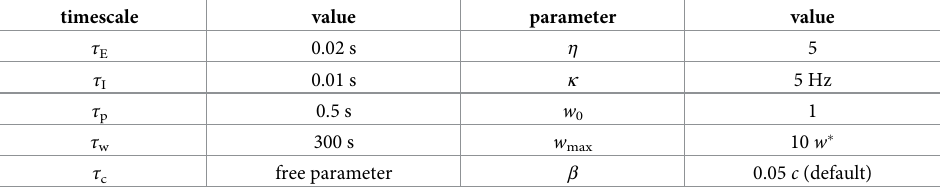
Table 2. Timescales, presynaptic inhibition and plasticity parameters in the rate network (unless specified differently). timescale